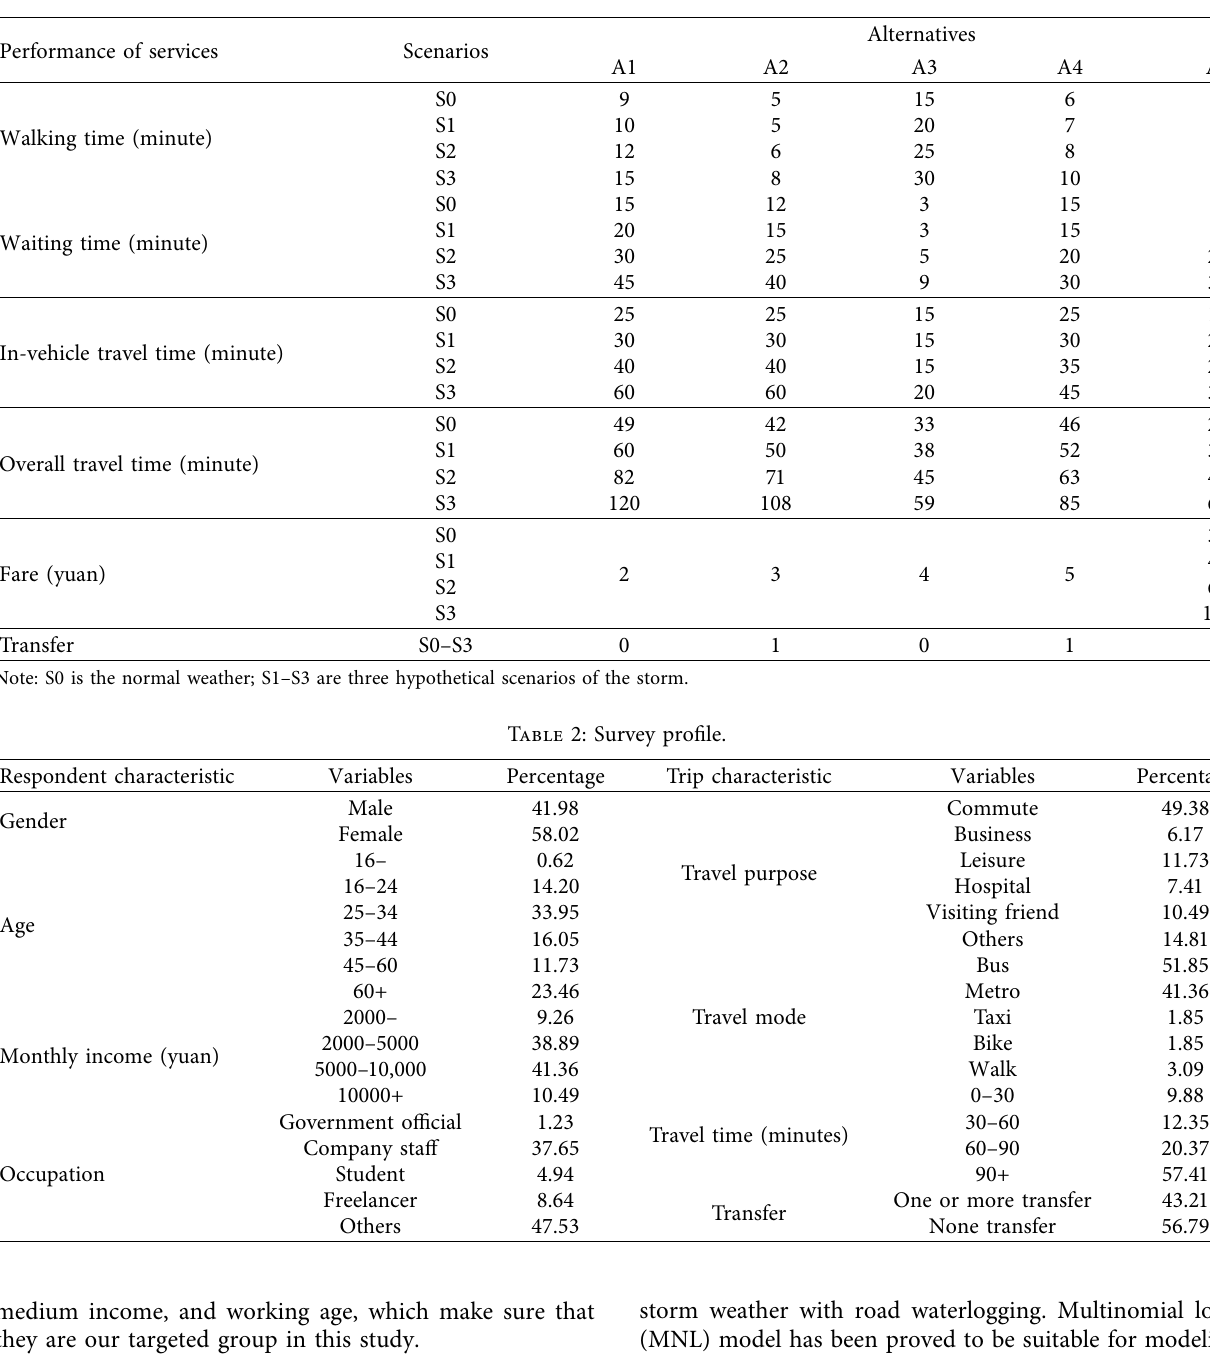
Table 1: Performance of services in scenarios.